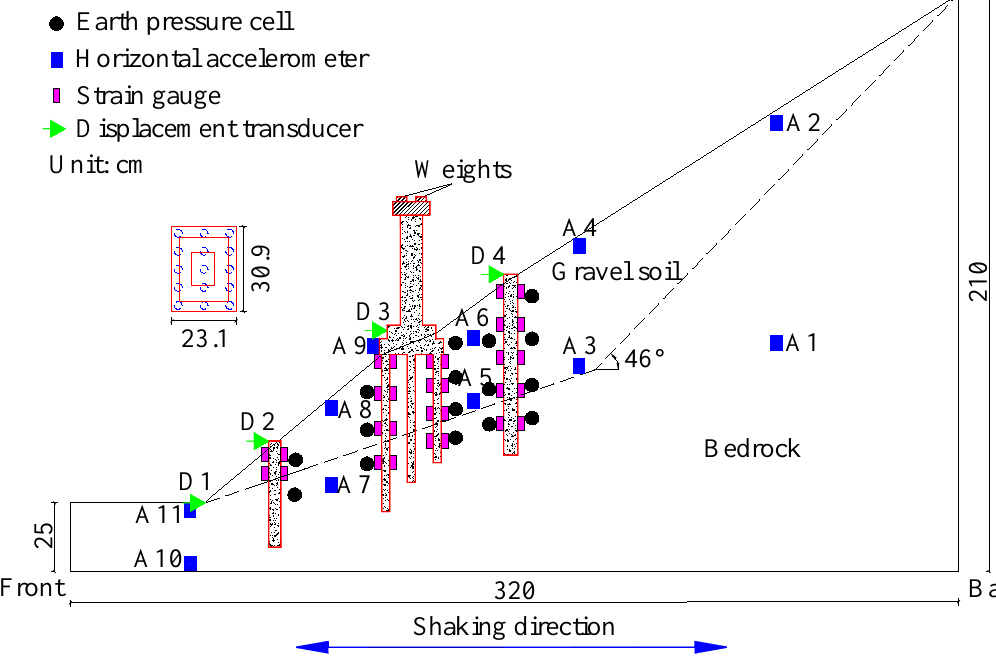
Figure 6. Longitudinal section of test model.